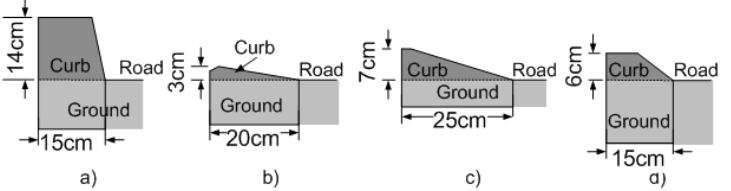
Figure 2. Types of road curbs: ( a ) Road-sidewalk, ( b ) island, ( c ) parking entry, ( d ) low height road-sidewalk,